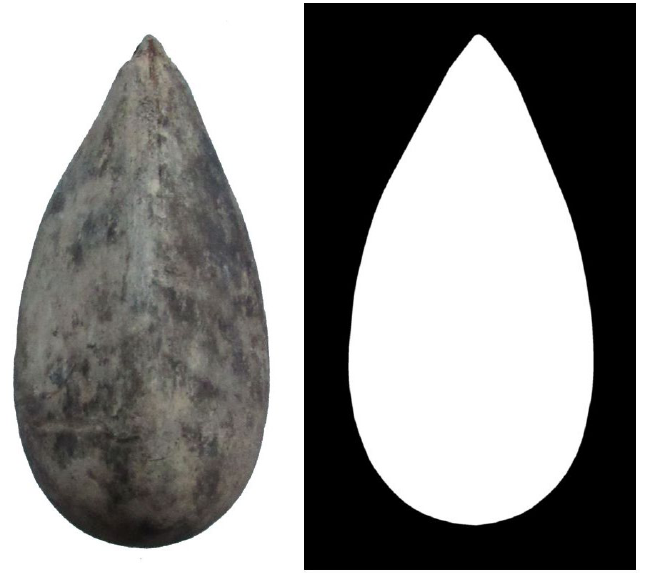
Figure 1. ( Left ) The image of a seed of A. natalia (Balslev & A.J. Hend.) Barfod (Arecaceae). ( Right ) the corresponding convex Hull.